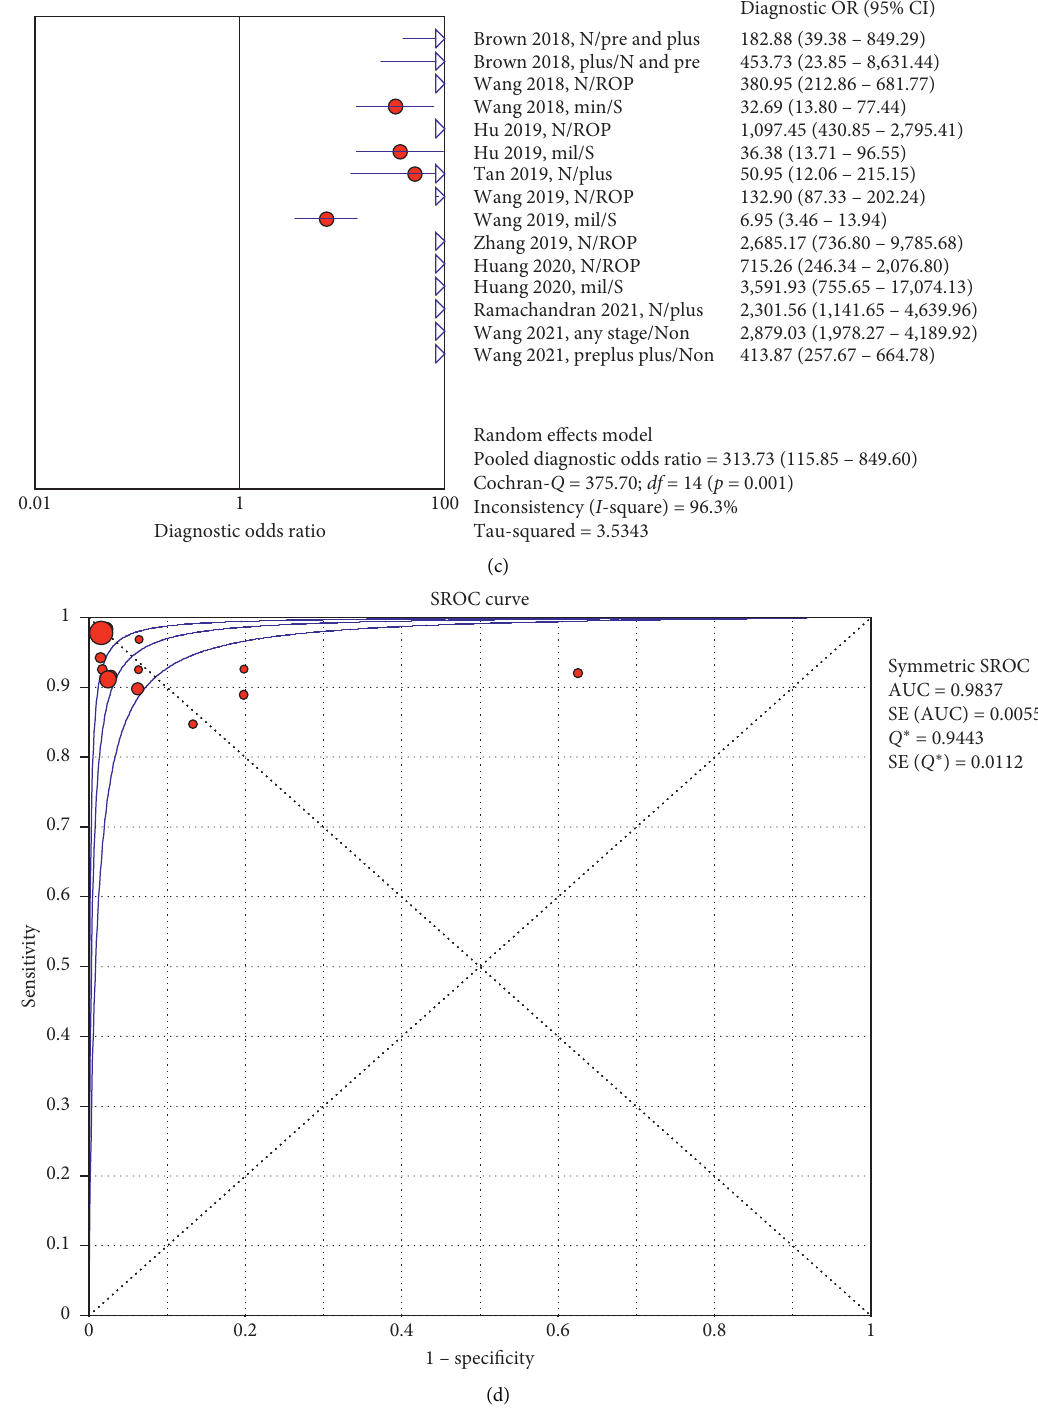
Figure 2: Performance of the DL models for detecting and grading ROP in primary analyses. Forest plots of sensitivities (a), specificities (b), and diagnostic odds ratios (DOR) (c), with respective confidence intervals, respectively, as well as to assess the heterogeneity in accuracy estimates across studies. Plots of individual study results in ROC space with receiver operating characteristics curve for all classifiers included (SROC)